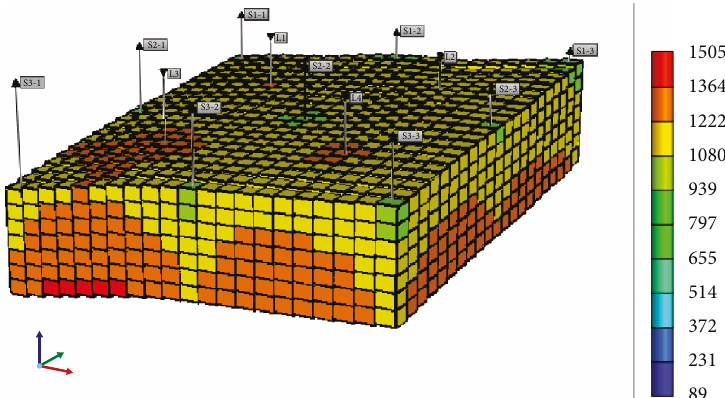
Figure 6: The distribution diagram of initial pressure. The unit is MPa.